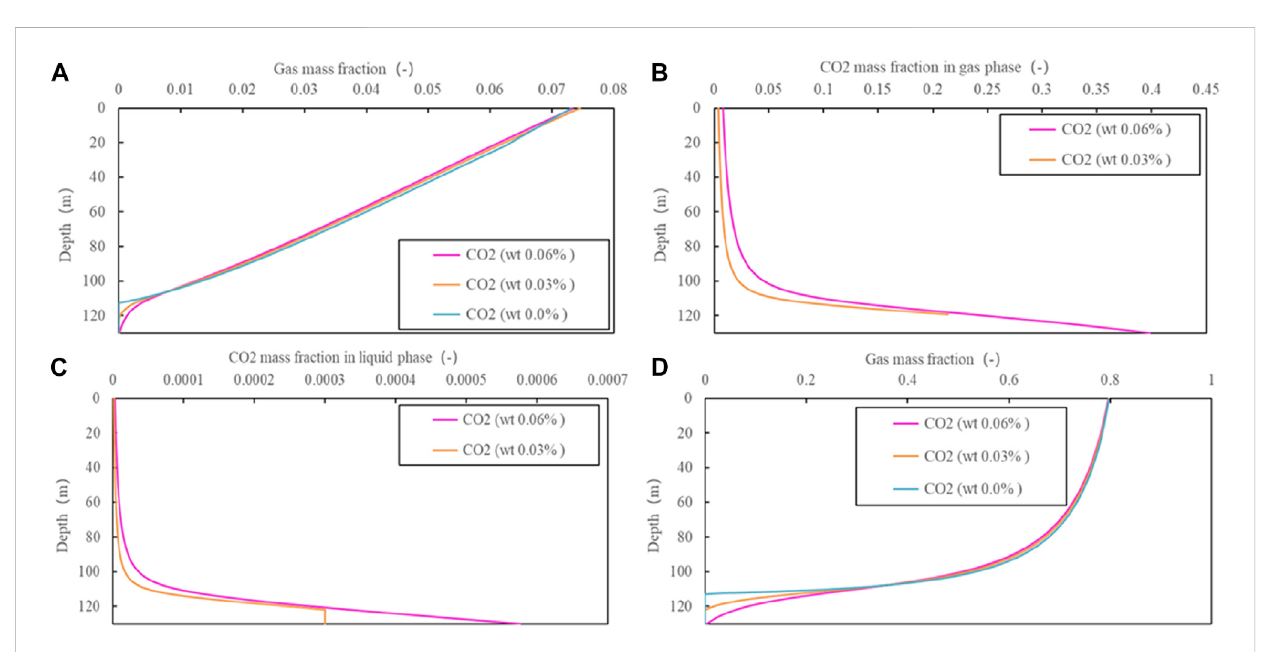
FIGURE 11 Simulated results by Hibiki and Ishii model for